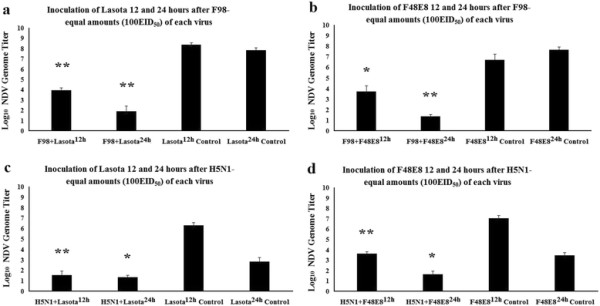
The replications of NDV (Lasota of F48E8) in ECE after inoculated first with AIV (F98 of H5NI) were measured by using the Real-time PVR. Superscript 12 h represtnets 12 hours interval between two viruses. Superscripts 24 h represents 24 hours interval between two viruses. Bars represent the standard deviations for two experiments carried out on three eggs. Statistical significance between the experimental group and control group was determined by the student’s t-test. *p<0.05, **p<0.01, ***p<0.001.